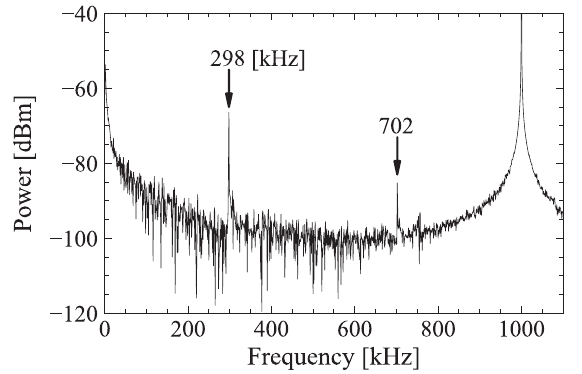
FIG. 1. Frequency spectrum of the quadrupole mode measured in the S-POD trap system at Hiroshima University (Ref. [1; 33]). The operating frequency of the LPT is 1 MHz. The bare betatron tune per unit AG cell is chosen to be ν 0 ¼ 0 . 16 . The number of ions confined in the LPT is about 2 × 10 6